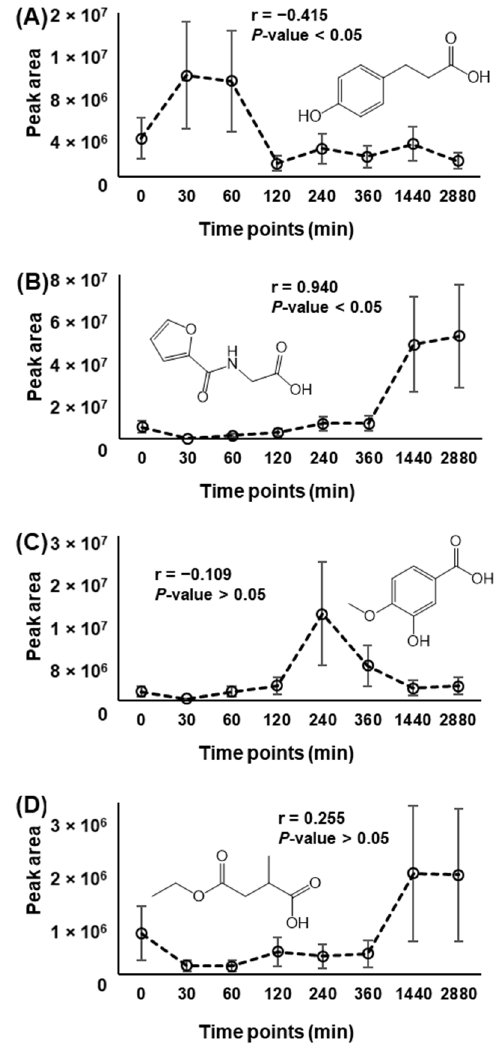
Figure 2. Representative examples of the use of PPMC coefficients (r) to evaluate phase I and II metabolisms of annotated metabolites (Table S2), as described in Section 2.7 of the main text. ( A ) Significant and negative r-value indicating a phase II metabolism. ( B ) Significant and positive r- value indicating a phase I metabolism. ( C ) Non-significant and negative r-value. ( D ) Non-significant and positive r-value.